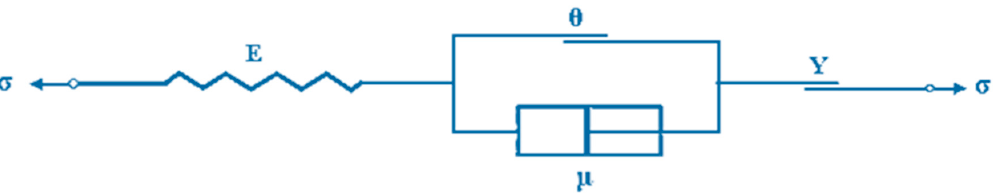
Figure 14. Illustration of ( a ) the proposed bilinear-viscoelastic model and ( b ) its representation with springs, dashpot and sliders. We note that the plastic zone, σ ≥ Y , of the modified Bingham model is omitted in the bilinear- viscoelastic model as it is to be used to describe impact situations. We also note that, in the bilinear- viscoelastic model, when θ 1 ≤ σ ≤ θ 1 , the equivalent elastic modulus, E (Figure 14) becomes: